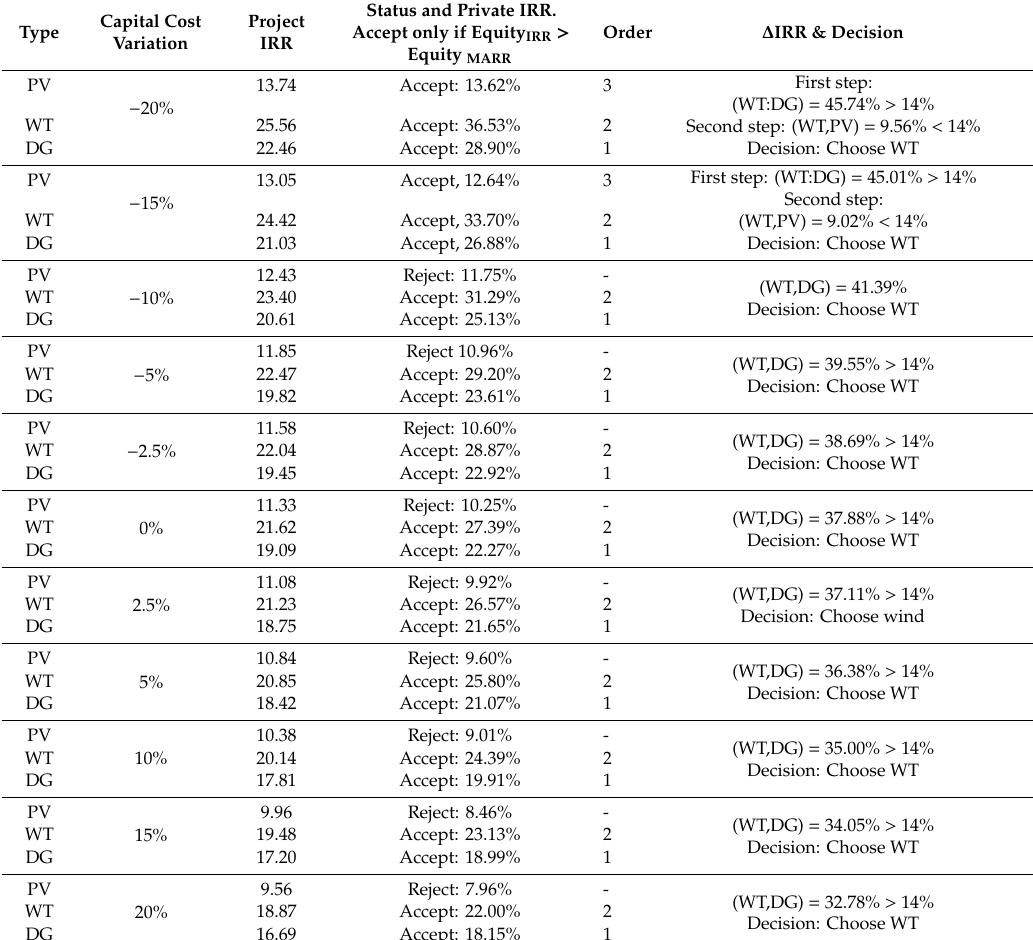
Table 4. 1 MW capital cost variation e ff ect on